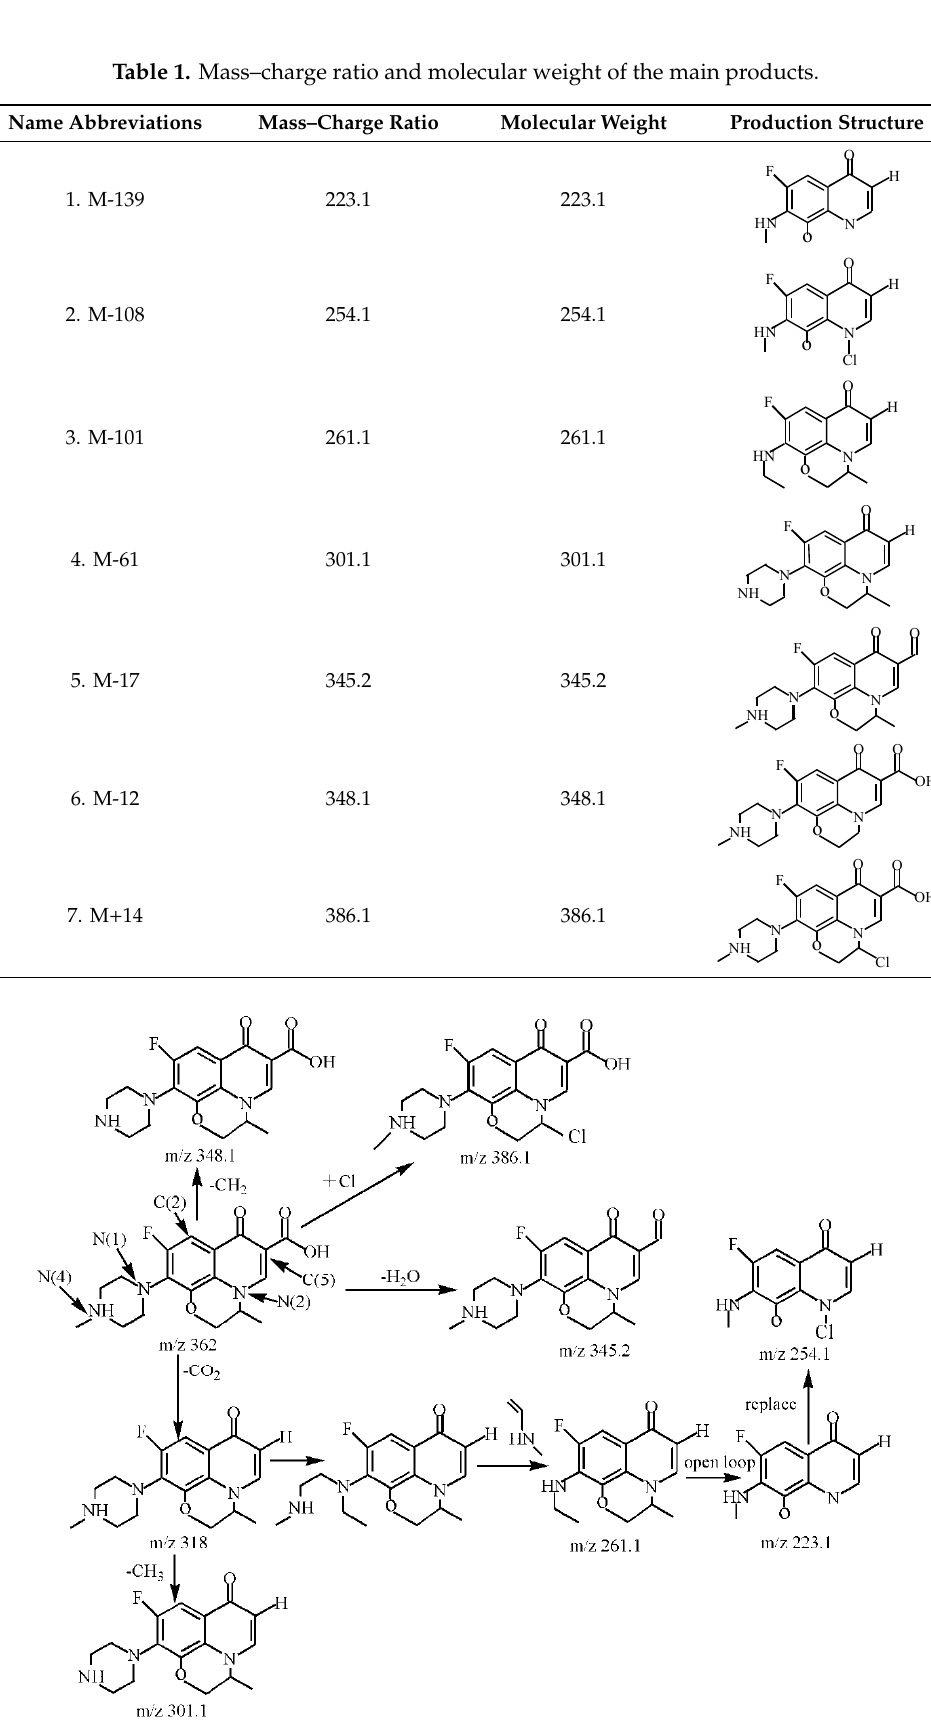
Figure 14. Degradation path of OFL.